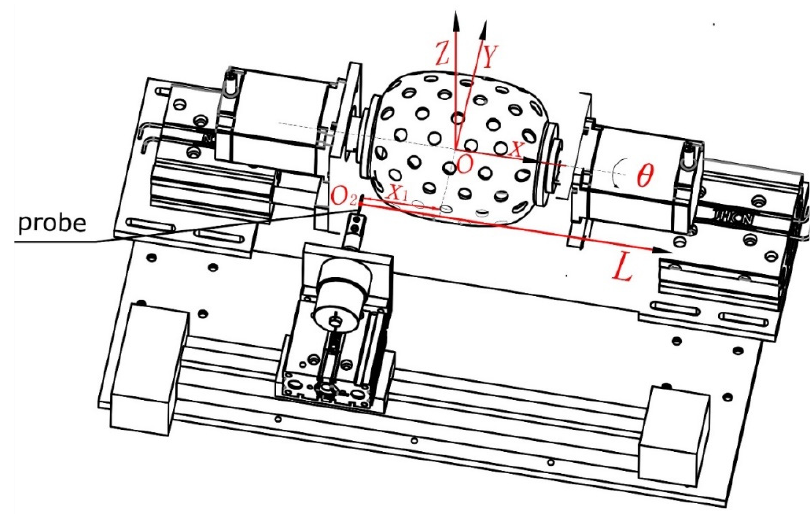
Figure 8. Three-dimensional positioning schematic diagram.